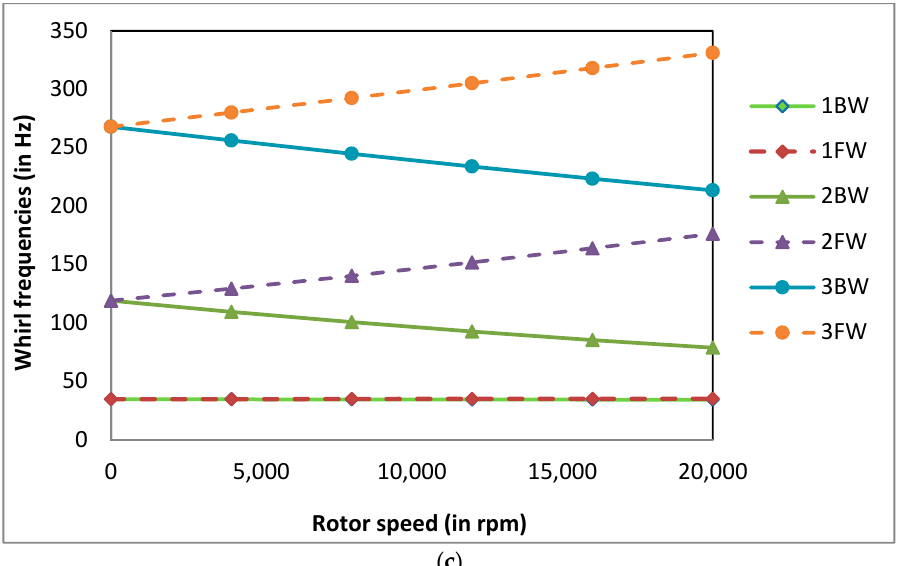
Figure 11. ( a ) Campbell diagram for the FG rotor-bearing system with a corrosion defect at X c /L = 0.4, d/R = 0.1, k = 0.5 and Δ T = 0K; ( b ) Campbell diagram for the FG rotor-bearing system with a corrosion defect at X c /L = 0.4, d/R = 0.1, k = 0.5 and Δ T = 300K; ( c ) Campbell diagram for the FG rotor-bearing system with a corrosion defect at X c /L = 0.4, d/R = 0.1, k = 0.5 and Δ T = 600 K.